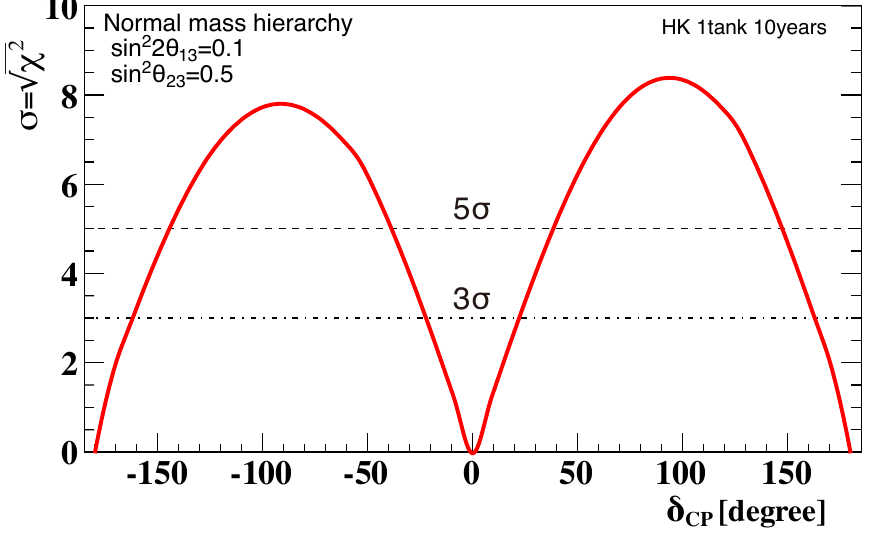
Figure 9. Sensitivity of Hyper-K in measuring δ CP